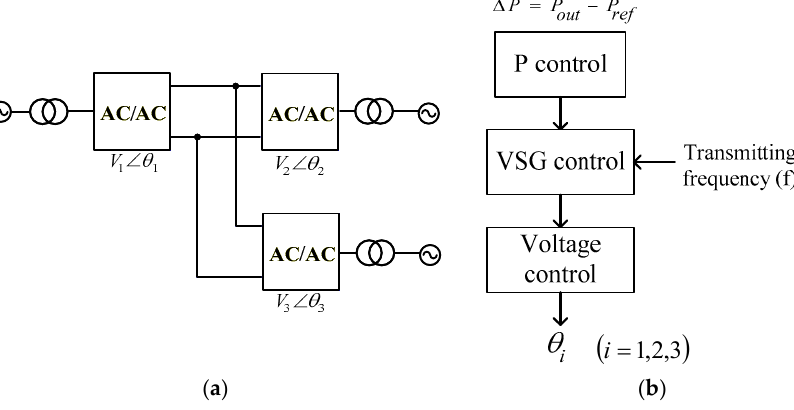
Figure 5. Configuration of the LCC ‐ MTLF: ( a ) Power flow configuration; ( b ) VSG control concept.